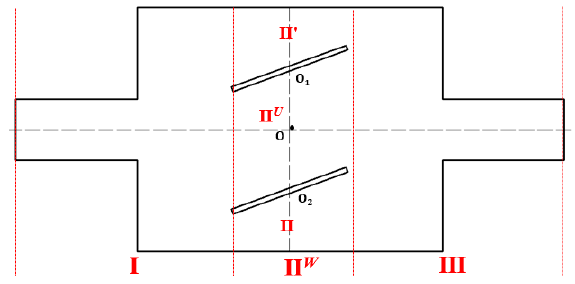
Figure 6. The REC with double baffles distributed transversely.